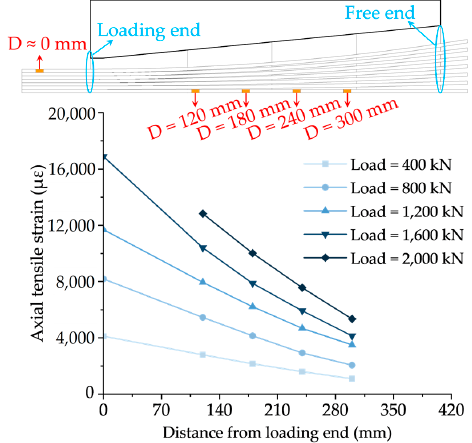
Figure 16. Axial tensile strains of T-1 at different load